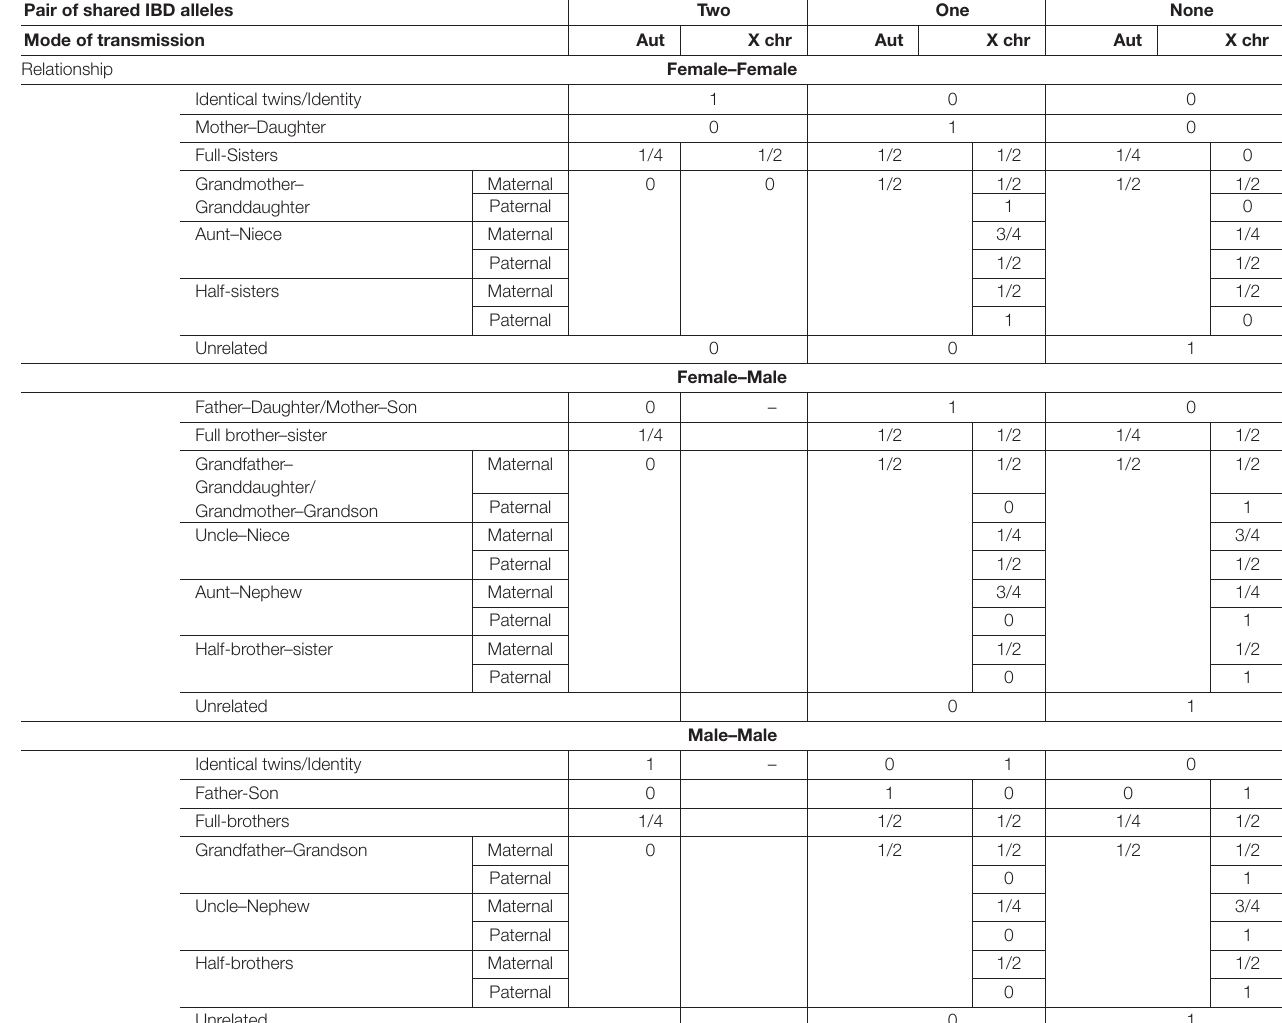
TABLE 4 | Probability of two individuals sharing two, one, or no pairs of identical-by-descent (IBD) alleles, assuming a specific kinship for both autosomal (Aut) and X-chromosomal (X chr) modes of genetic transmission. Pair of shared IBD alleles Two Mode of